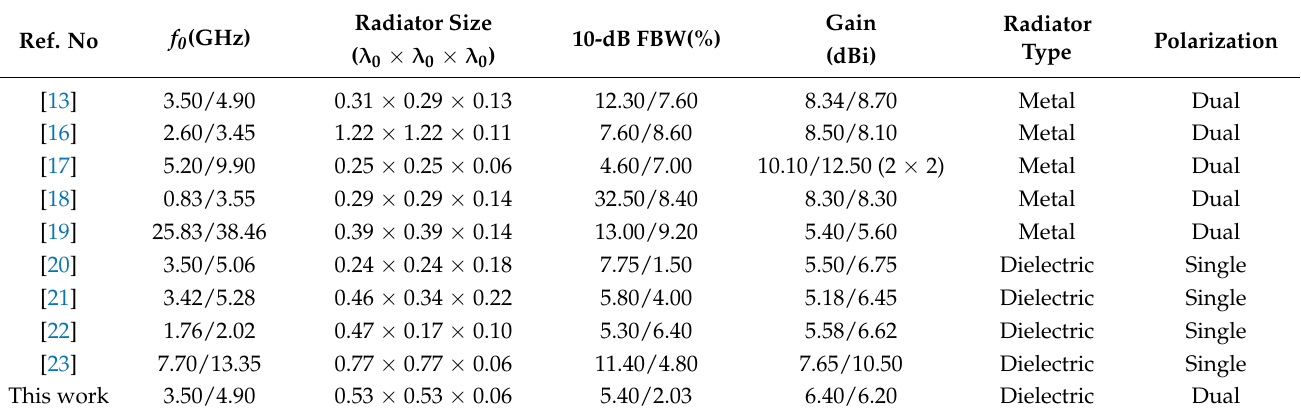
Table 1. The proposed antenna compared with other related